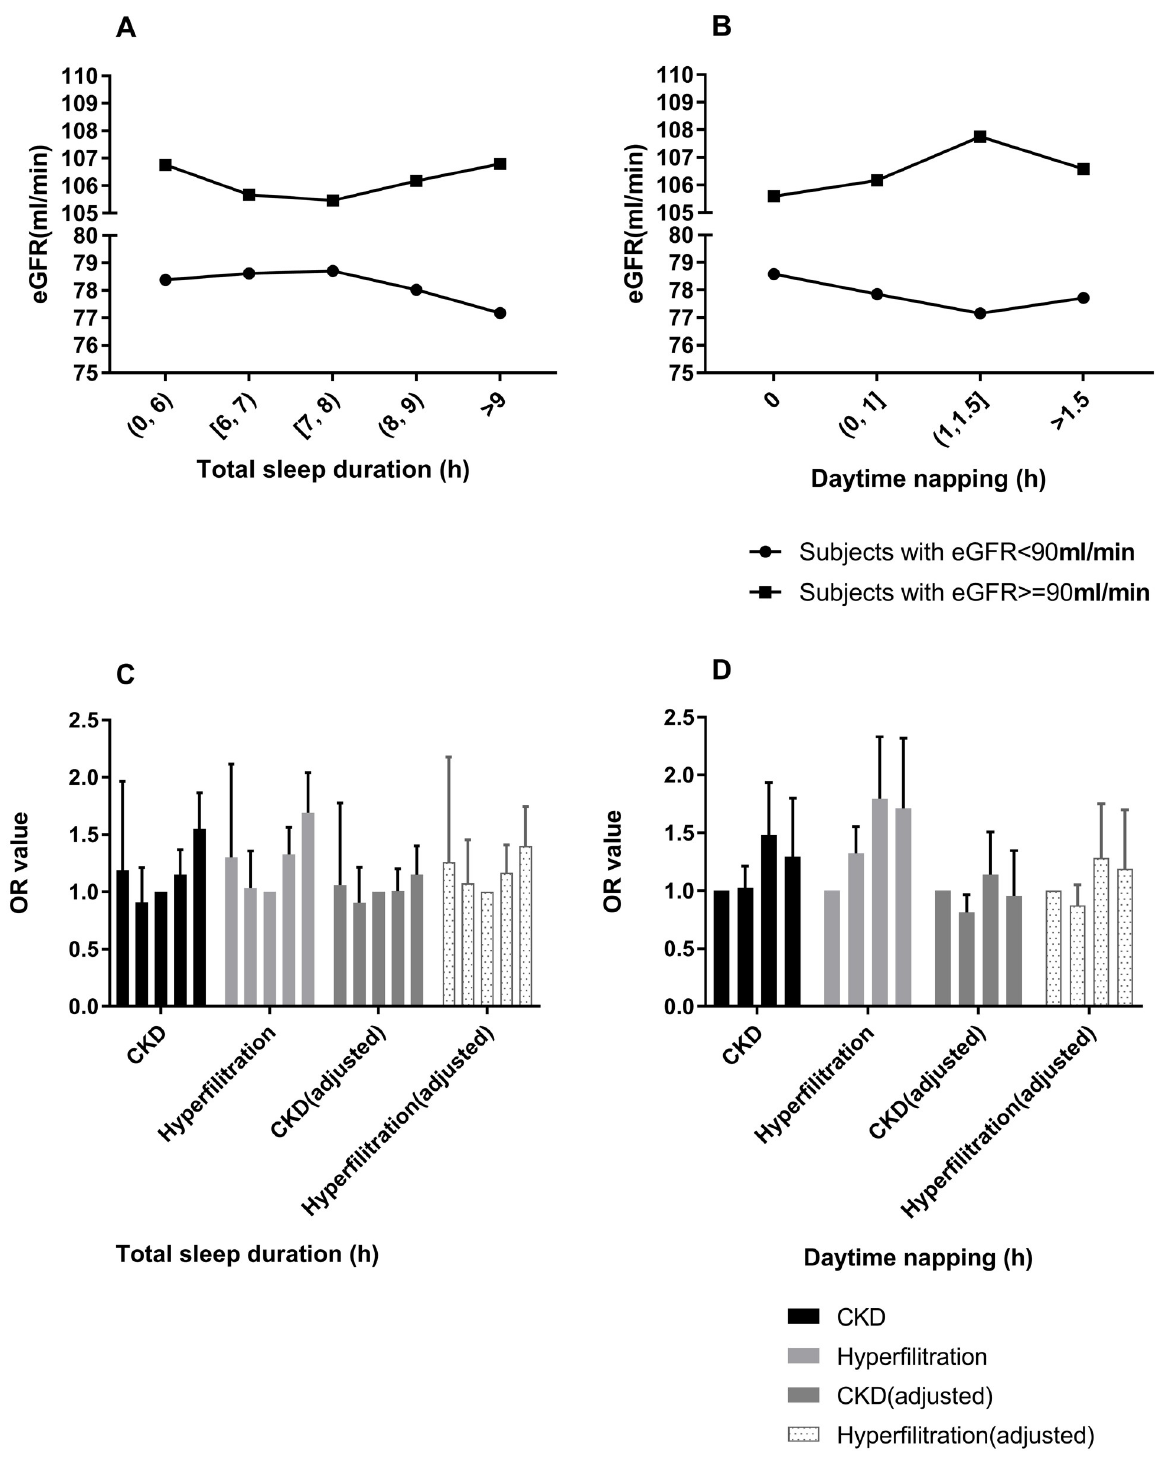
Fig 2. The association between sleep duration and eGFR. (A) The association between mean eGFR values and total sleep duration among subjects with < 90 ml/min and � 90 ml/min eGFR. (B) The association between mean eGFR values and daytime napping duration among subjects with < 90 ml/min and � 90 ml/min of eGFR. (C and D) Risks for hyperfiltration among subjects with � 90 ml/min eGFR and risks for CKD among subjects with < 90 ml/min eGFR, according to total sleep duration or daytime napping duration. The adjusted covariates included age, sex, BMI, HC, WC, alcohol consumption and smoking habits, physical exercise, TG, TC, HDL, LDL, GGT, blood glucose and blood pressure. CKD was defined as eGFR < 60 ml/min, and hyperfiltration was defined as eGFR � 135 ml/min.